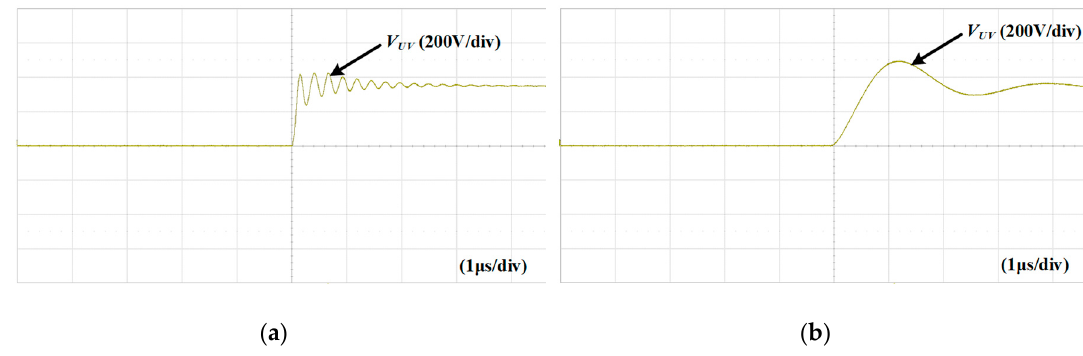
Figure 11. Experimental results of line-to-line voltage in motor input terminal in the case of ( a ) without output filter; and ( b ) with dv/dt filter.